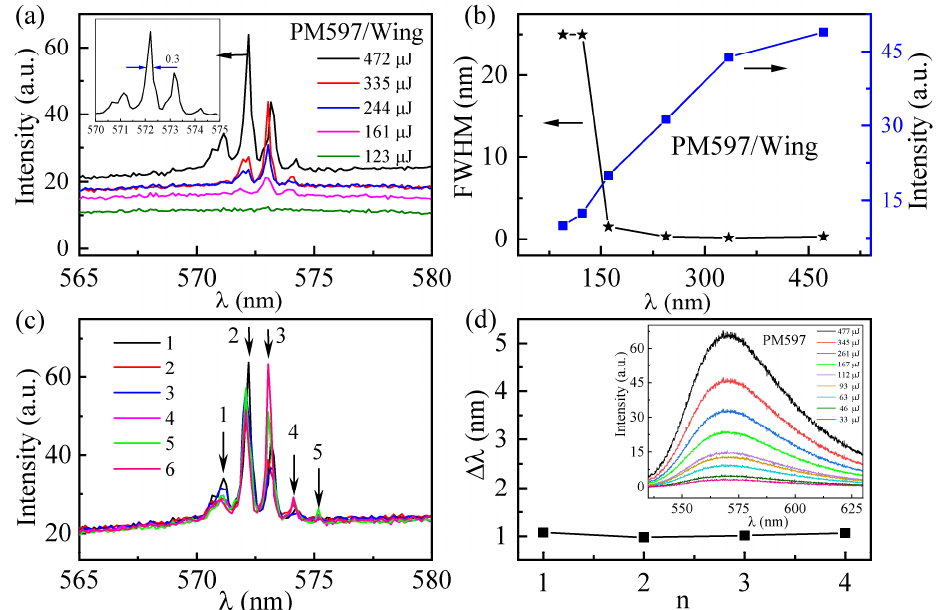
Figure 8. ( a ) Emission spectra of PM597/Wing under different pumping energies; ( b ) The emission intensity (blue squares) and FWHM (black stars) as a function of the pumping energy for PM597/Wing; ( c ) Single shot spectra of PM597/Wing with fixed pumping position and pumping energy (595 µ J), the arrow indicates the peak; ( d ) the interval between adjacent patterns from the marked peaks in ( c ). Inset: Fluorescence spectrum of dye PM597.